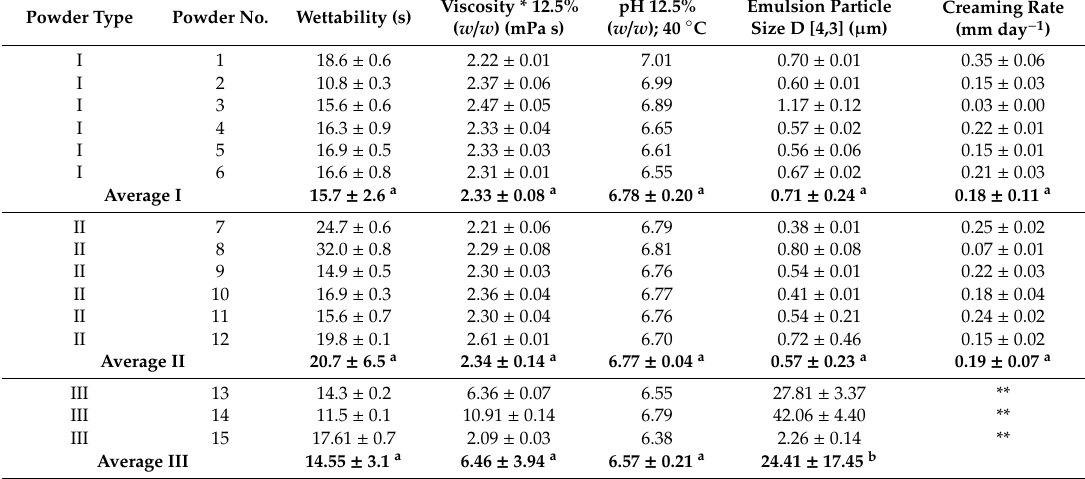
Table 6. Reconstituted properties of commercially available infant and follow-on formula powders. Powder